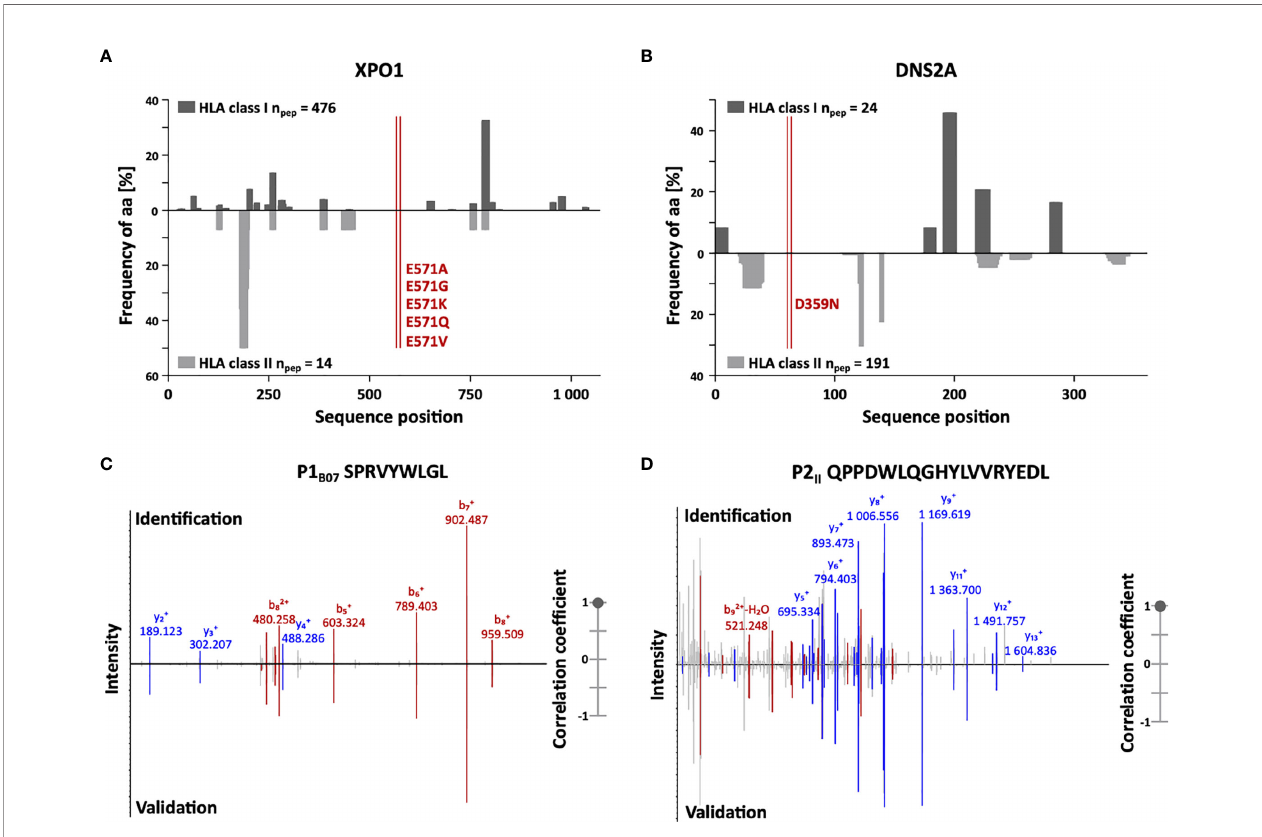
FIGURE 2 | Immunopeptidome coverage of common CLL mutation sites and spectral validation of CLL-associated peptides. (A, B) Hotspot and dark spot analysis by HLA class I (above x-axis) and HLA class II (below x-axis) peptide clustering. All identi fi ed HLA class I- and HLA class II-presented peptides of the CLL and benign tissue immunopeptidomes were mapped to their amino acid positions within the respective source protein. Representative examples are shown for (A) XPO1 and (B) DNS2A. Representation frequencies of amino acid counts for the respective amino acid position (x-axis) were calculated and are indicated on the y-axis. The red lines highlight the analyzed mutation sites of recurrent CLL-associated mutations. (C, D) Representative examples of the validation of the experimentally eluted (C) HLA class I-restricted peptide P1 B07 and (D) the HLA class II-restricted peptide P2 II using synthetic isotope-labeled peptides. Comparison of fragment spectra (m/z on the x-axis) of peptides eluted from primary CLL patient samples (identi fi cation) to their corresponding synthetic peptides (validation). The spectra of the synthetic peptides are mirrored on the x-axis. Identi fi ed b- and y-ions are marked in red and blue, respectively. The calculated spectral correlation coef fi cients are depicted on the right graph, respectively. aa, amino acid; n pep , number of peptides.